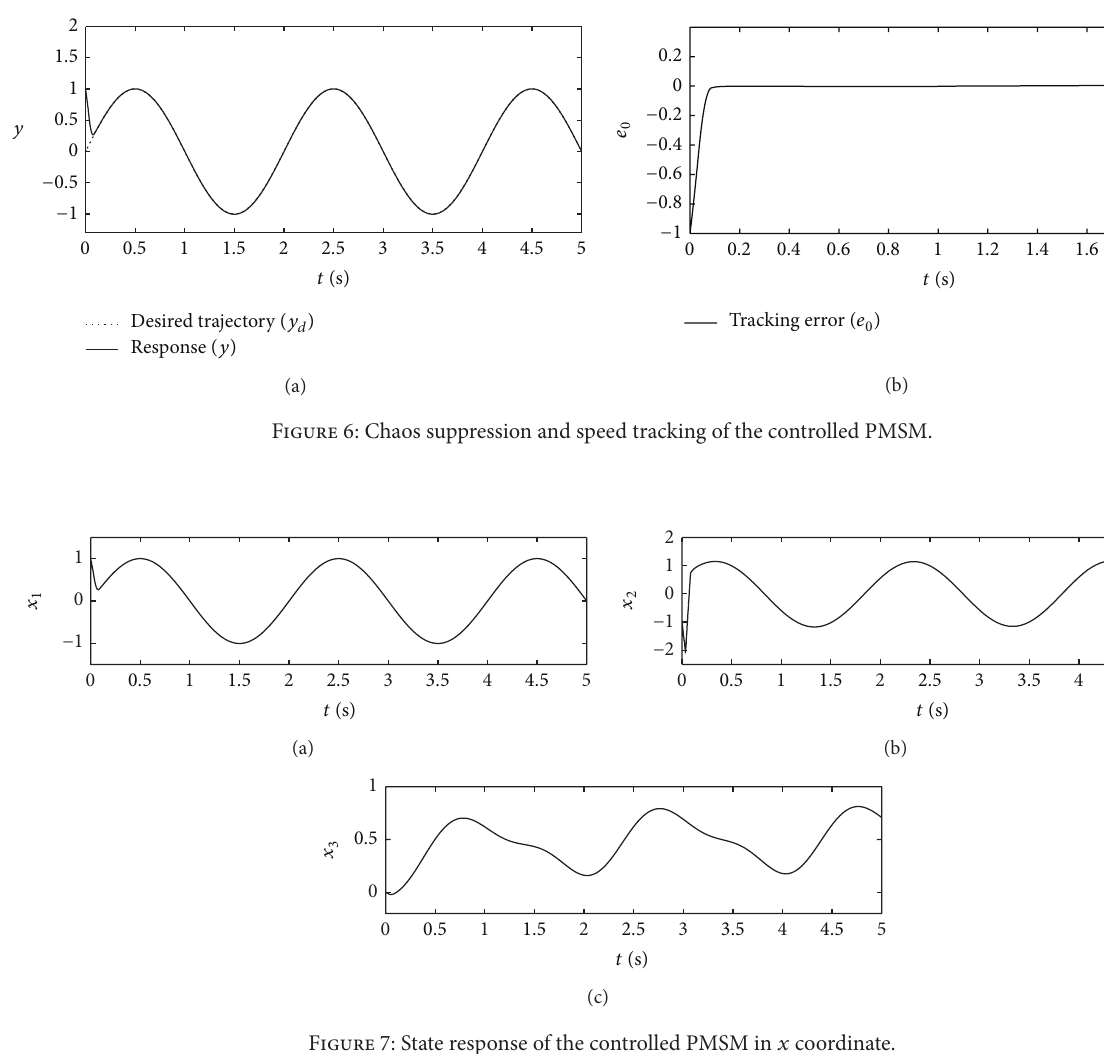
Figure 7: State response of the controlled PMSM in 𝑥 coordinate.